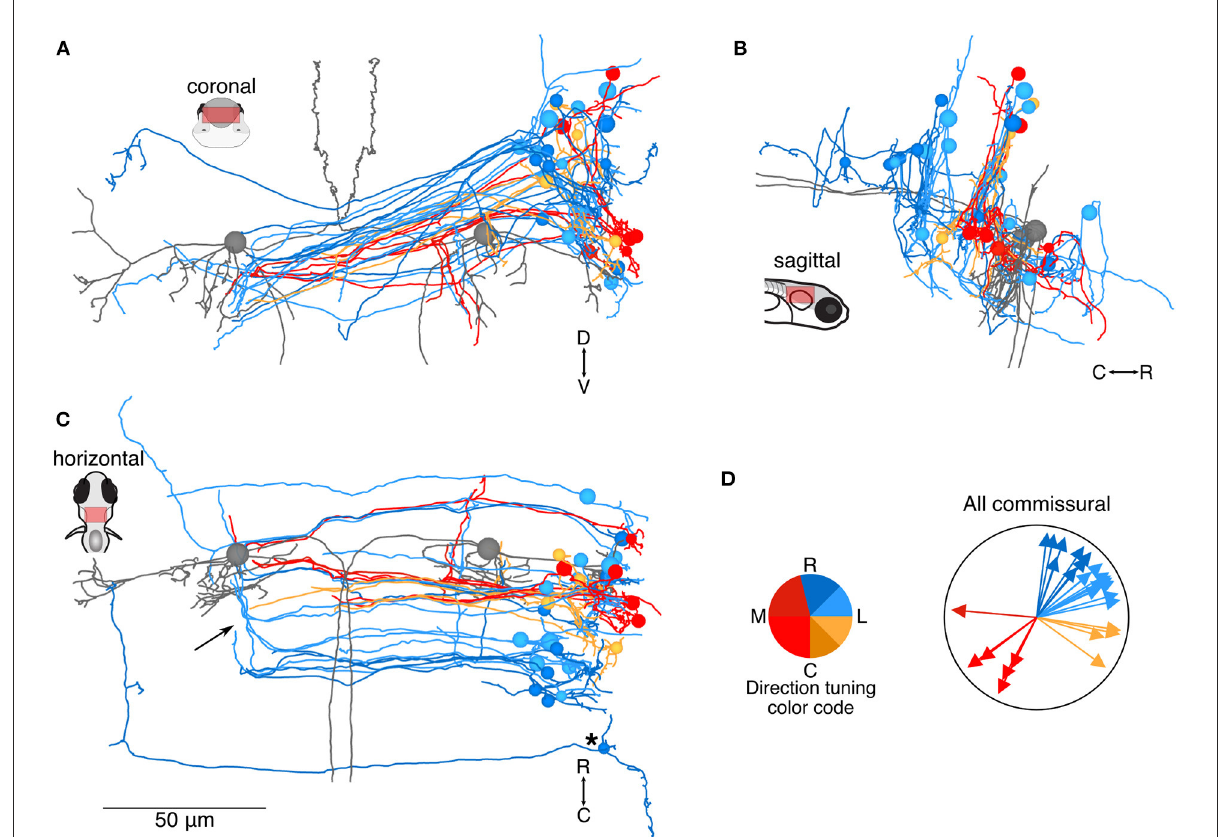
FIGURE2 Location and directional tuning of identified commissural neurons receiving utricular input. (A) Coronal projection of reconstructions of 31 commissural neurons that receive direct utricular afferent input, colorized by their inferred directional tuning [see color code, (D) ]. In addition, the left and right Mauthner cells are shown in gray to facilitate comparisons with other results. Note that the Mauthner cells are shown as spheres. Nearly all commissural utricular neurons follow a similar axon projection path. (B) Sagittal view of the same neuron reconstructions as in (A) . Most of these commissural neurons are located caudally to the Mauthner cell bodies. (C) Horizontal view of the same neurons as in (A) . Arrow points to a position where several commissural utricular axons can be seen to turn rostrally, in the same mediolateral position as the Mauthner cell body. Asterisk indicates the presumed tangential neuron described in text. Scale bar applies to (A–C) . (D) Summary of the inferred directional tuning of commissural utricular neurons. Vector direction indicates the computed directional tuning of each neuron. Arrow